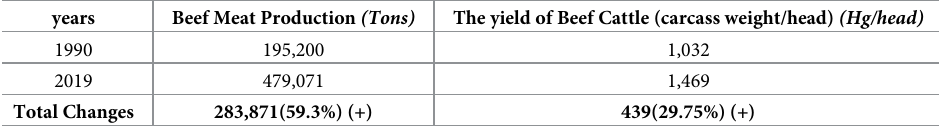
Table 3. Overall changes in beef production and carcass yield